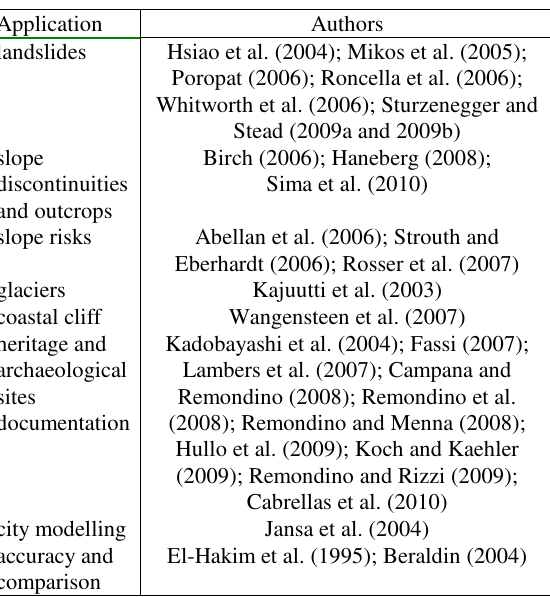
Table 1. Overview of applications of terrestrial laser